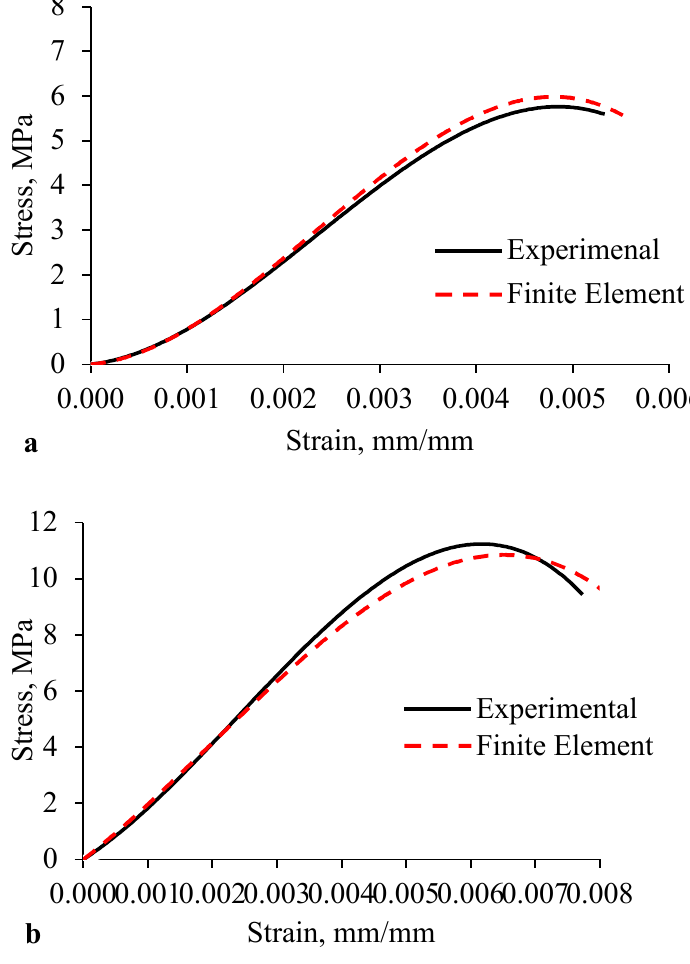
Figure 8. Comparison of the FE and experimental axial stress-strain curve. ( a ) Hollow prisms and ( b ) grouted prisms.